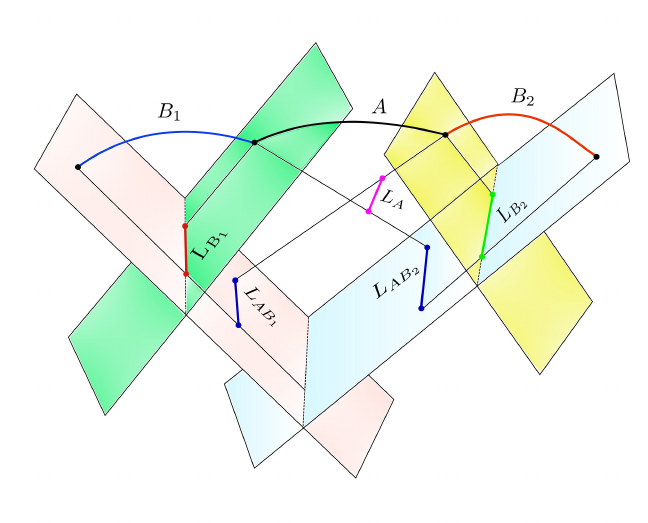
Figure 1: Schematics of the extremal geodesics anchored on different subsystems corresponding to the computation of entanglement negativity for a single interval in a finite temperature GCFT . The null planes descending from the boundary 1 + 1 endpoints are shown. The non-trivial contributions to the geodesic lengths land on the crossings of the corresponding null